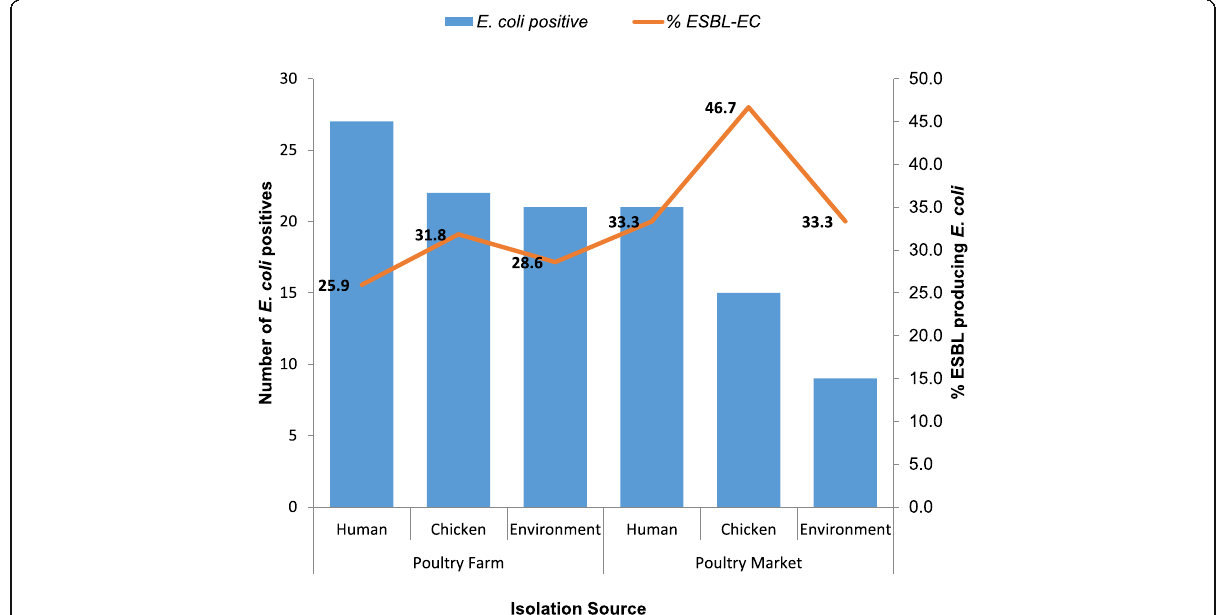
Fig. 2 Proportion of ESBL-EC among positive E. coli isolates from humans, chickens, and poultry environment in Abuja, Nigeria, 2019. The number of E. coli positive isolates are plotted as bars on the primary axis while the proportion of these positive isolates which are ESBL-EC in percentages are plotted as a line graph on the secondary axis. The various data points on the line graph are also displayed on the